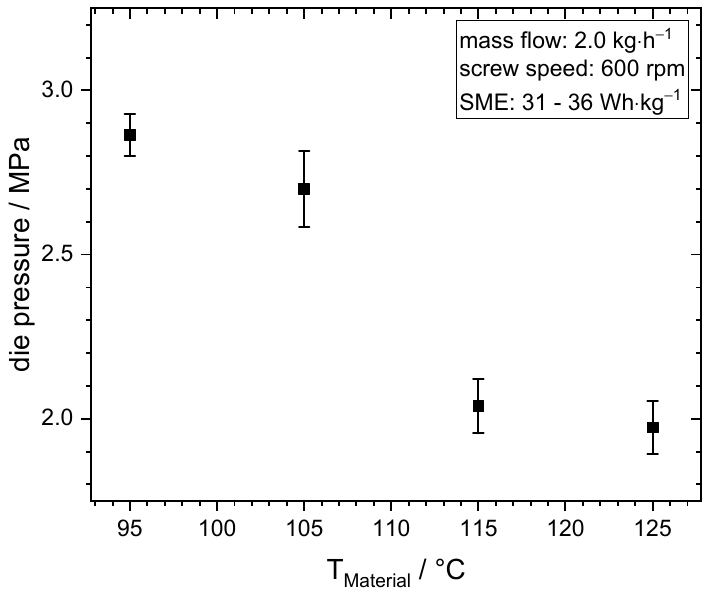
Figure 3. Die pressure as a function of material temperature at constant mass flow (2.0 kg · h − 1 ) and screw speed (600 rpm).